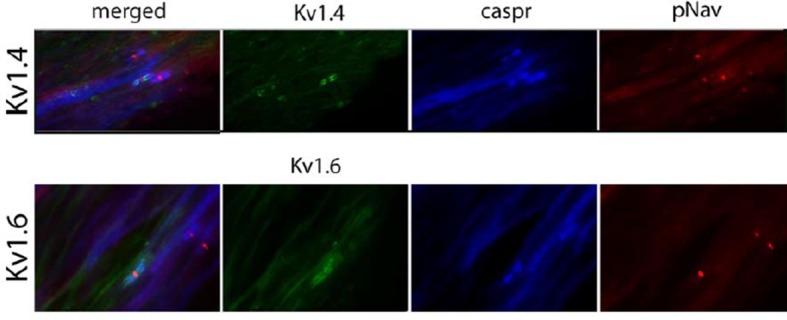
DOI:
http://dx.doi.org/10.7554/eLife.12661.025